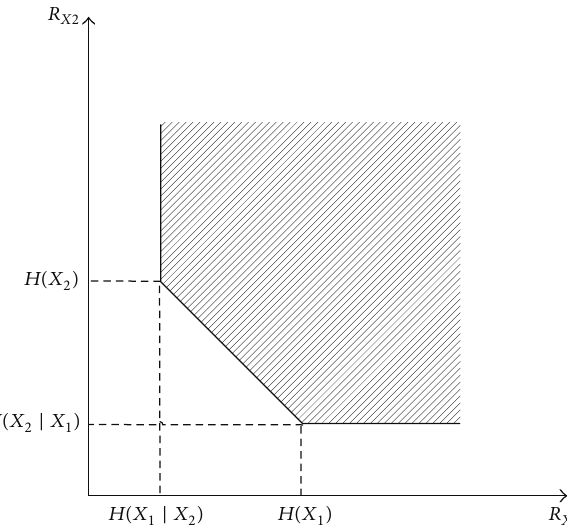
Figure 1: Rate region for Slepian-Wolf coding (two